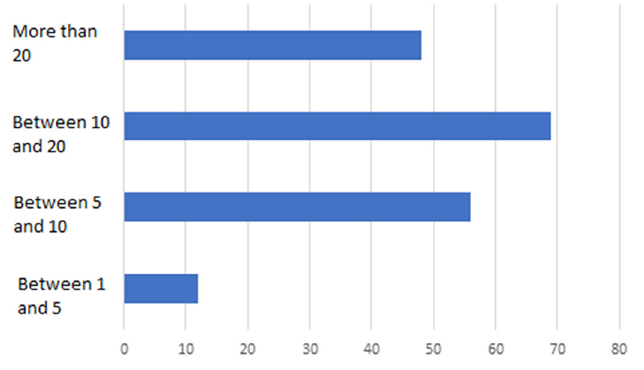
Fig. 3. Number of oral surgery procedures performed by the respondents ( n = 185).